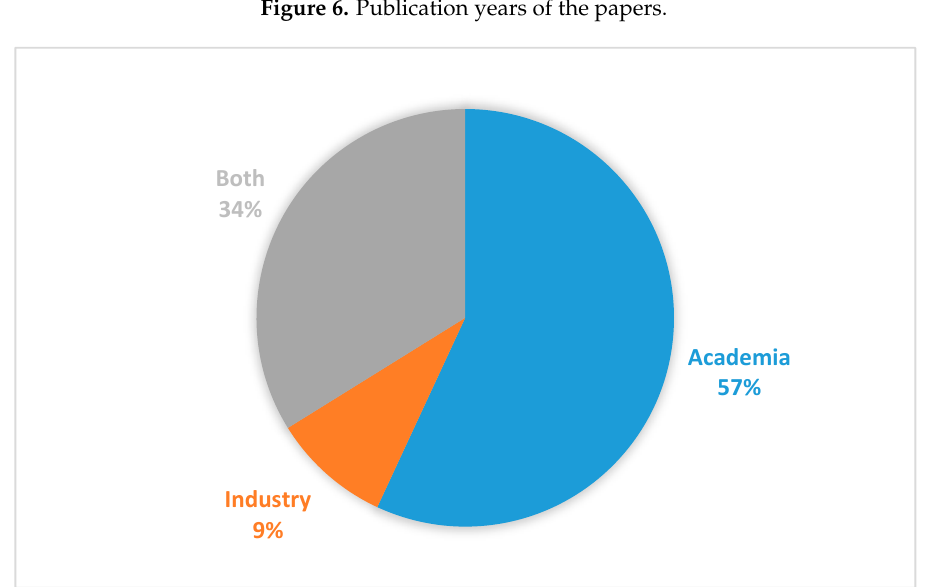
Figure 8. Distribution of the papers by the countries of the authors.